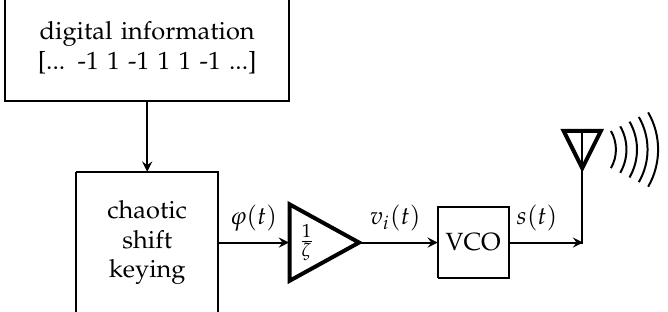
Figure 4. Block diagram for the joint mono and bistatic RadComm